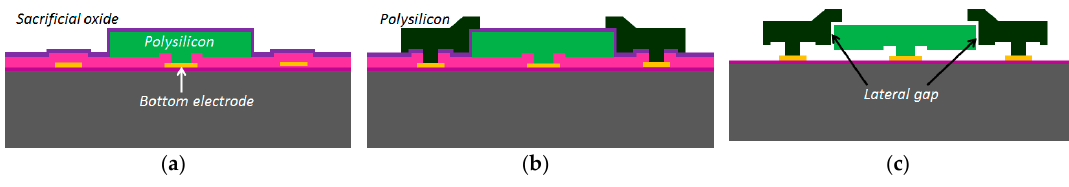
Figure 19. Fabrication of lateral narrow gaps in a polysilicon-based process: ( a ) Conformal growth of sacrificial oxide to define lateral gaps; ( b ) Growth and patterning of polysilicon electrodes; ( c ) Release of polysilicon structure after removal of sacrificial oxide.